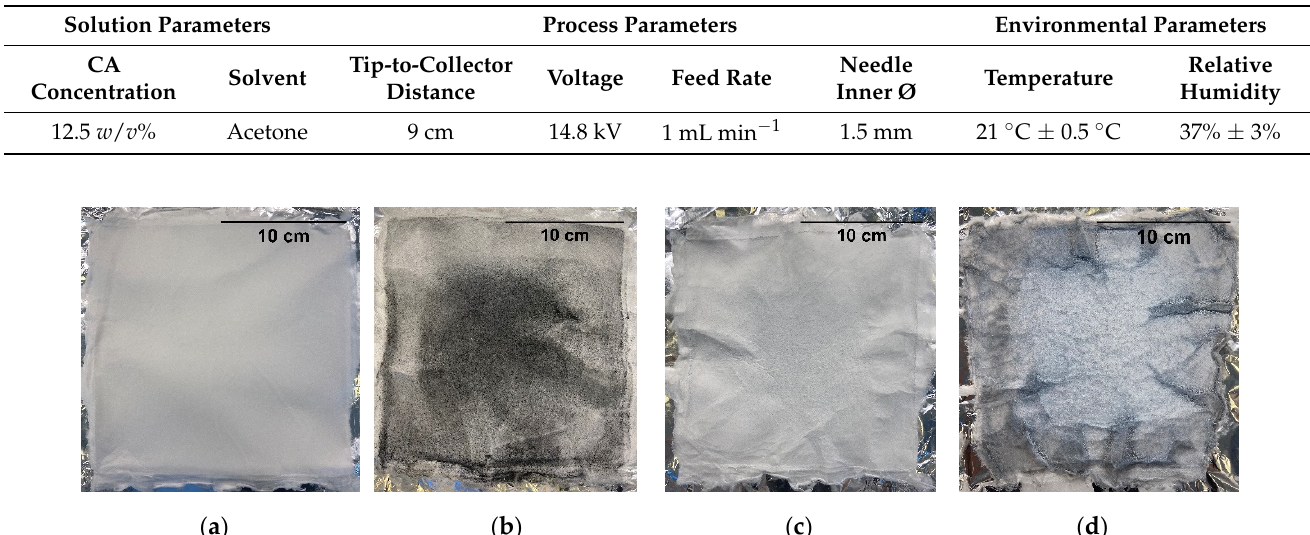
Figure 4. Electrospun filter materials developed in this study: ( a ) pure CA; ( b ) CA/AC; ( c ) CA/TiO 2 ; ( d ) composite.